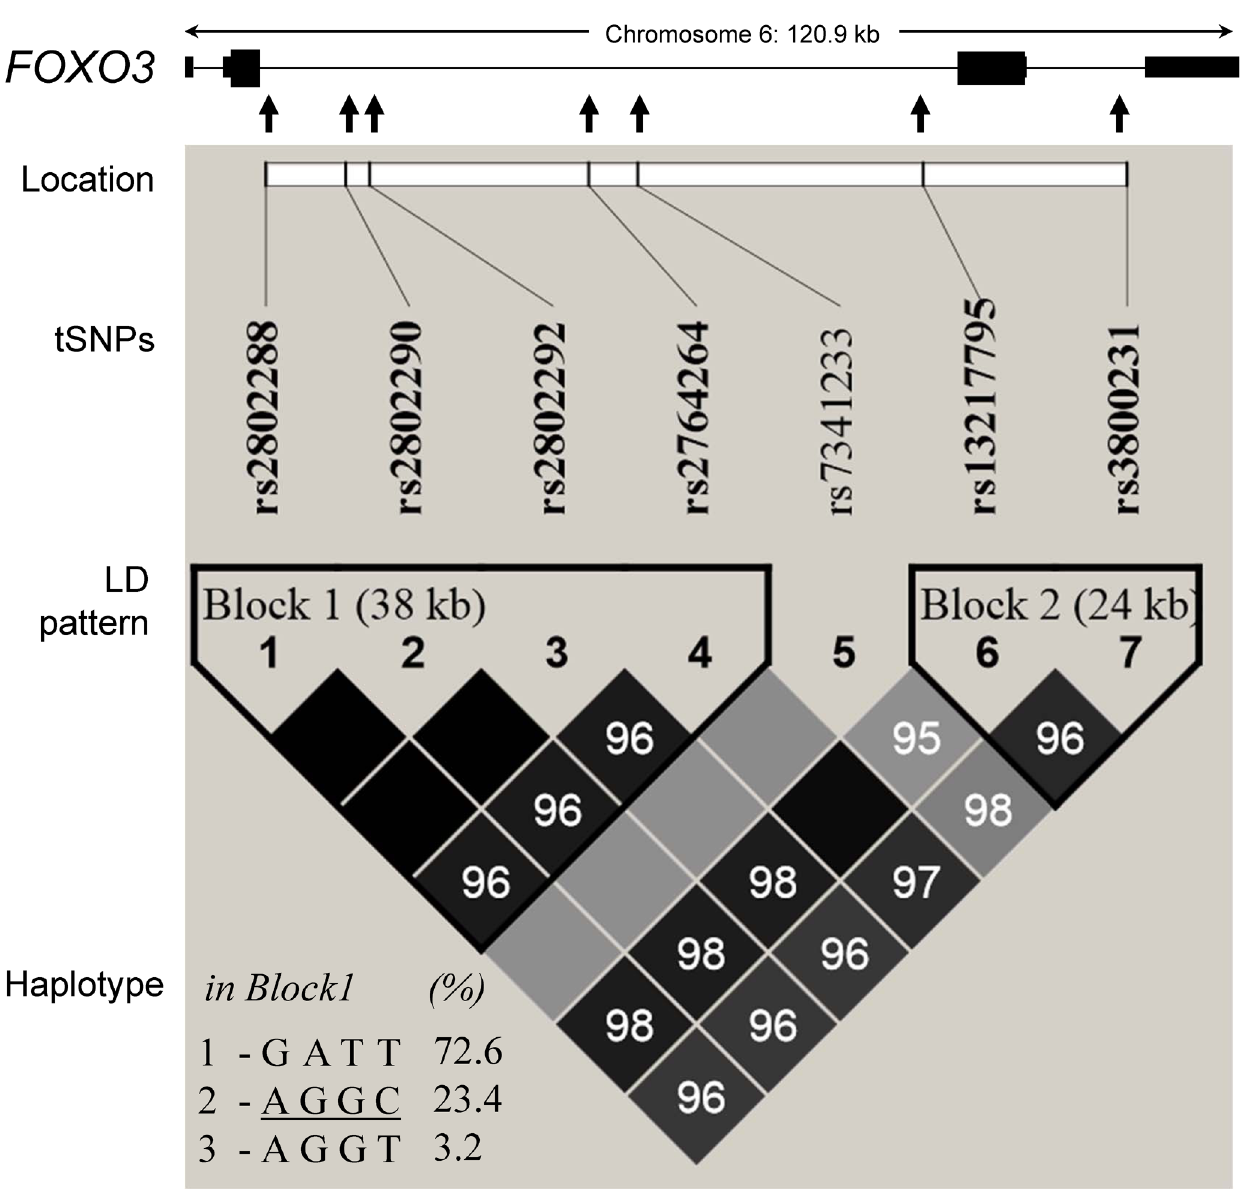
Fig 1. Graphical representation of the polymorphisms and LD structure across FOXO3 in the subjects of this study. The FOXO3 locus consists of four exons (thin dark-shaded boxes represent UTRs, and thick dark-shaded boxes represent coding exons). The thin lines represent introns. The relative locations of seven variants are listed. Two linkage disequilibrium (LD) blocks are defined. The measures of LD (D ’ ) among paired of variants are shown graphically by color (r 2 ). A white box represents very low LD, and a dark box represents very high LD. The constitutions and frequencies of three common haplotypes in block 1 are